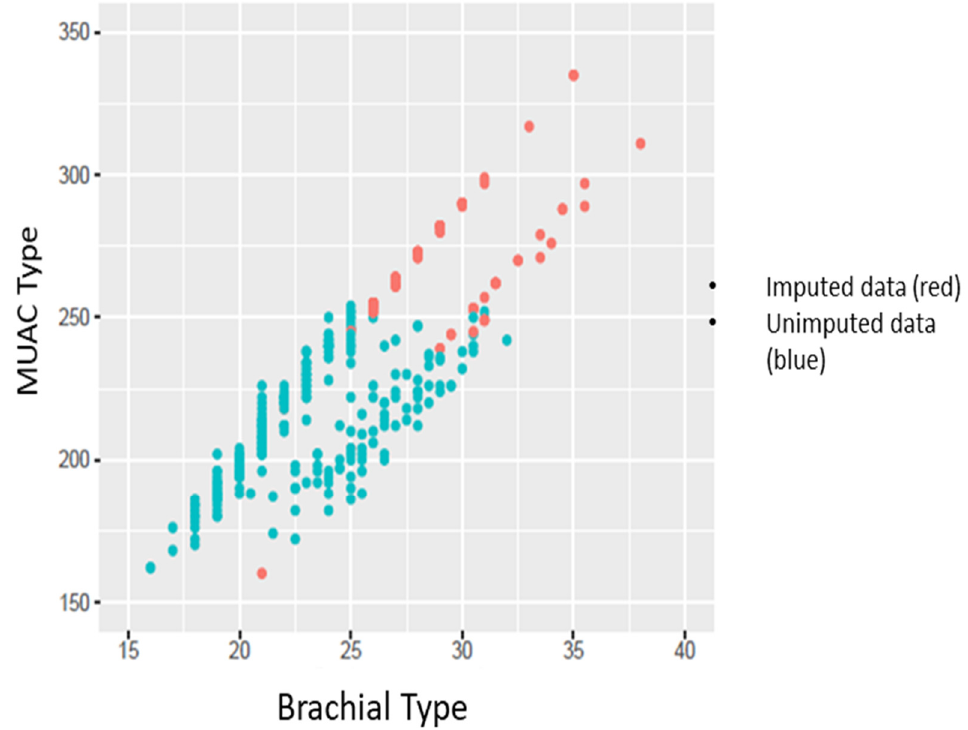
Figure 2. Imputation of MUAC values for children that could not be measured in the sample. MUAC Type: millimetres. Brachial Type: centimetres.